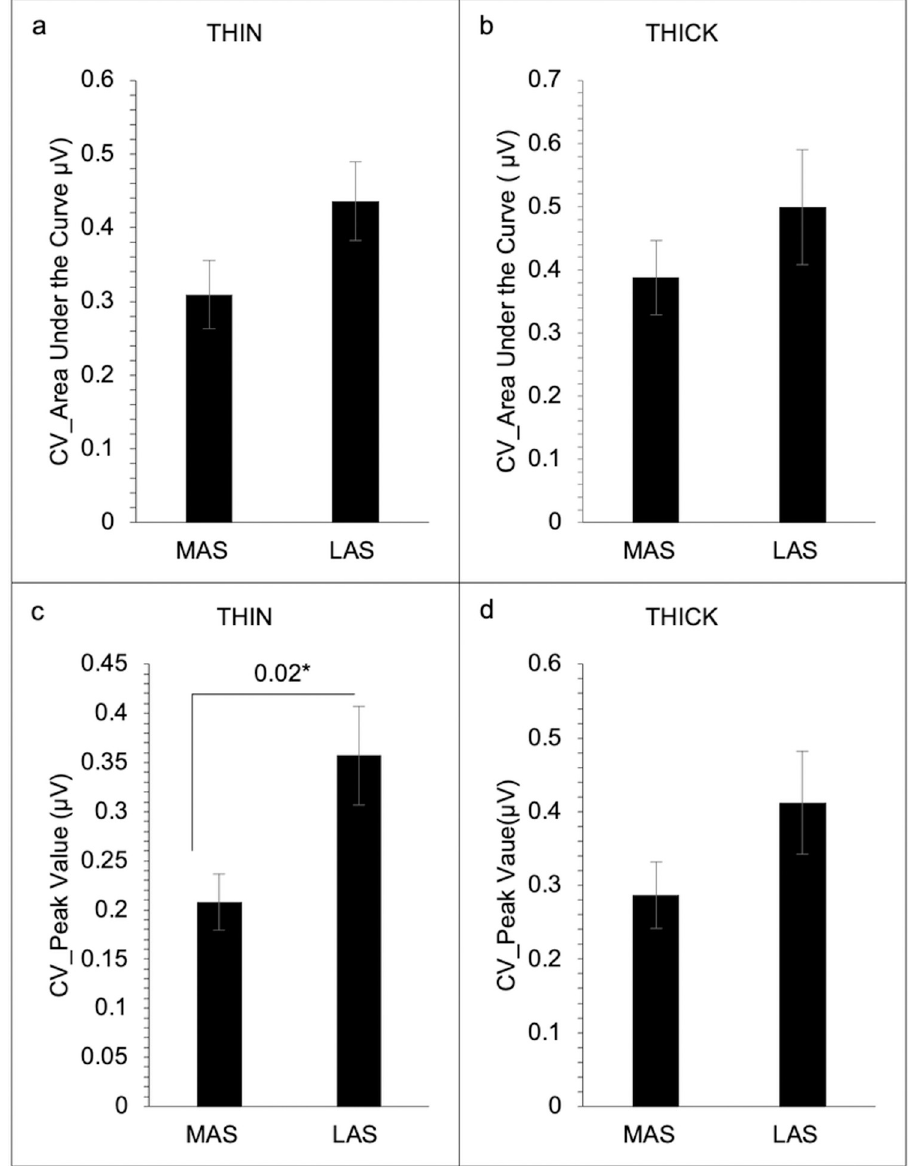
Fig 4. Coefficient of variation on EMG measures for laryngeal muscles groups for Most Affected Side (MAS) and Least Affected Side (LAS) across both swallow conditions (N = 23). Area under the curve for the laryngeal muscle group for the thin swallow condition (a), and area under the curve for the laryngeal group for the thick swallow condition (b). Peak amplitude for the laryngeal muscle group during the thin swallow condition (c), and peak amplitude for the laryngeal muscle group during the thick swallow condition (d). Error bars reflect standard